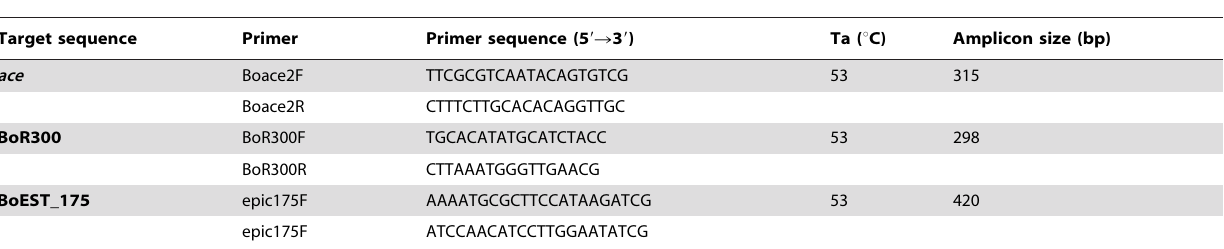
Table 1. Primer sequences and parameters of the RT-PCR and qPCR